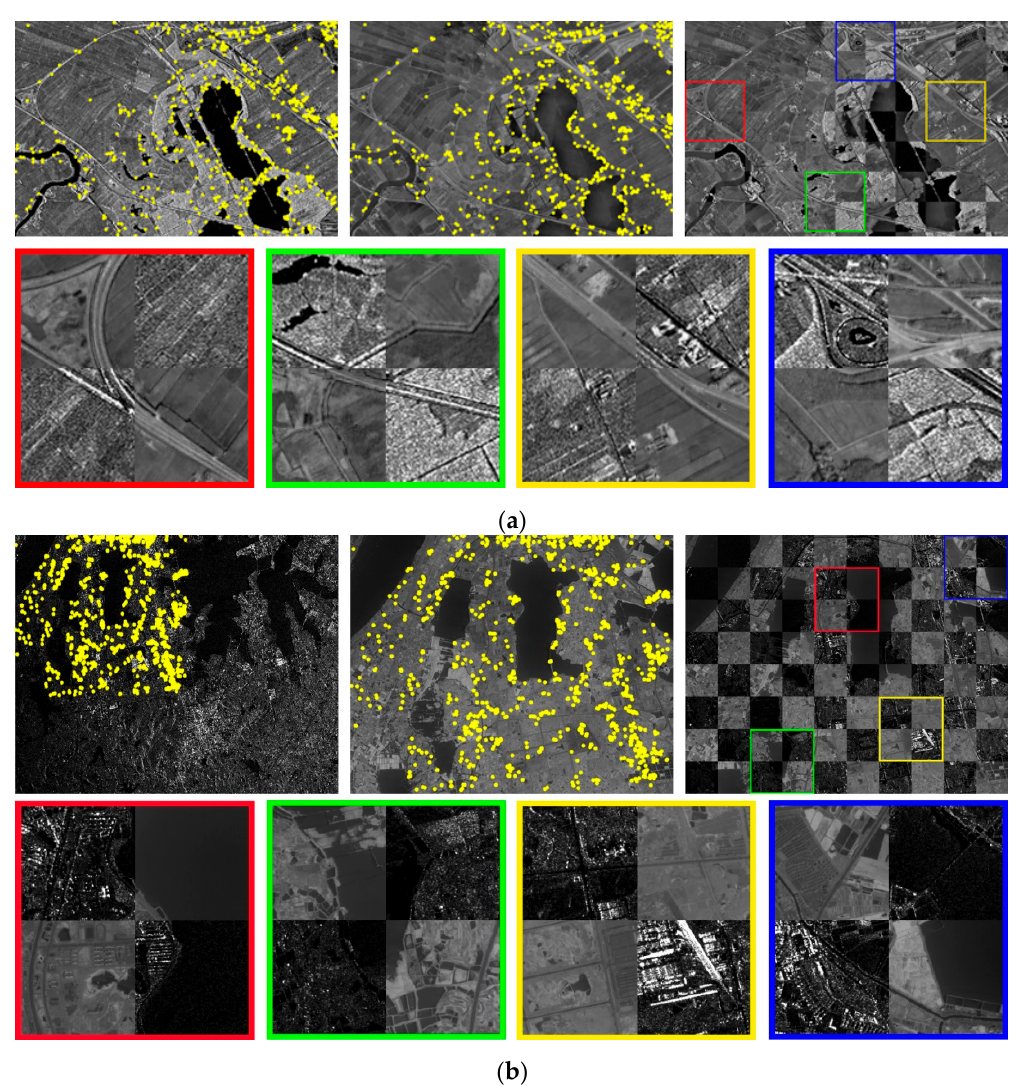
Figure 12. Registration results of the proposed method. ( a ) Registration result of image pair 9; ( b ) registration result of image pair 12. In the figures, the yellow dots in the top-left image are the control points detected by the proposed method on the SAR image. The yellow dots in the top-middle image are the control points detected by the proposed method on the optical image. The top-right image shows the registration result. Four small sub-regions marked by red, green, yellow, and blue boxes are magnified to show the registration details in the bottom of the corresponding images.